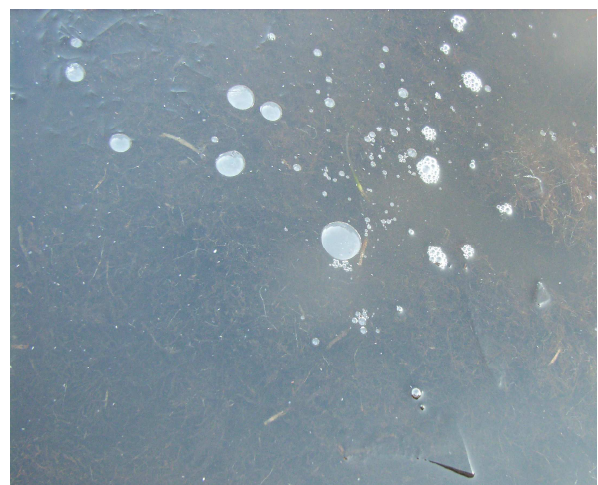
1 Fig. 9. CH 4 bubbles trapped under a newly frozen water surface Figure 9. CH bubbles trapped under a newly frozen water surface in an inundated polygon 2 4 in an inundated polygon center in the North section on 18 Septem- ber 2007. A sampled bubble showed a CH 4 concentration of 804 center in the North section on 18 September 2007. A sampled bubble showed a CH 3 parts per concentration of 804 parts per thousand. 4